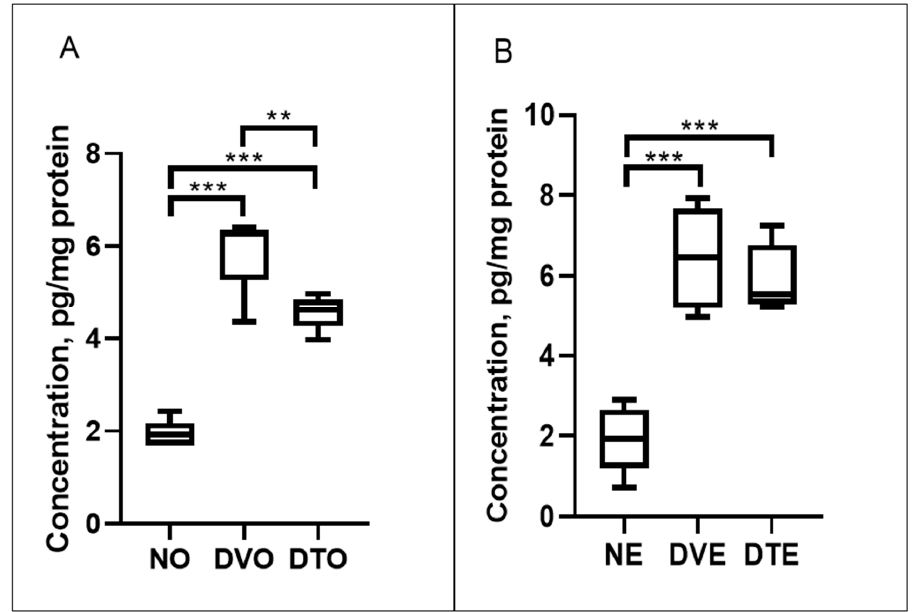
Figure 9. Effect of TRF on the retinal vascular endothelial growth factor (VEGF) expression in rats with STZ-induced diabetes is presented using box and whisker plots. Boxes show median, lower quartile, and upper quartile, whereas whiskers show the data variability outside the upper and lower quartiles. Rats were treated by ( A ) oral and ( B ) topical routes over 12 weeks of experimental period NO: Normal rats with oral vehicle treatment, DVO: Diabetic rats with oral vehicle treatment, DTO: Diabetic rats with oral TRF treatment. NE: Normal rats with topical vehicle treatment, DVE: Diabetic rats with topical vehicle treatment, DTE: Diabetic rats with topical TRF treatment, n = 6; ** p < 0.01; *** p < 0.001.